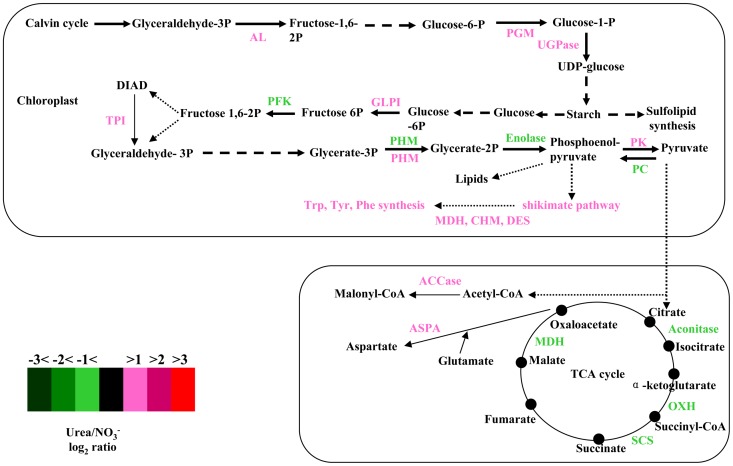
Pathways for starch synthesis, glycolysis, aromatic amino acid synthesis and the TCA cycle.Enzymes that are involved in these pathways are labeled with colors that indicate the fold change (log2) in their transcript levels in urea-grown cells relative to nitrate-grown cells (color code is provided in the figure). Dashed lines mean that no differentially expressed genes were detected in these pathways. AL, aldolase; PGM, phosphoglucomutase; UGPase, UDP-glucose-pyrophosphorylase; PFK, phosphofructokinase; TPI, triose-phosphate isomerase; PHM, phosphoglycerate mutase; PK, pyruvate kinase, PC, pyruvate carboxylase; OXH, oxoglutarate dehydrogenase; SCS, succinyl-CoA ligase; MDH, malate dehydrogenase; EPSPS, 3-phosphoshikimate 1-carboxyvinyltransferase; CHM, chorismate mutase; DES, dehydroquinate synthase; ASPA, aspartate aminotransferase; ACCase, Acetyl-CoA carboxylase; GLPI, glucose-6-phosphate isomerase.